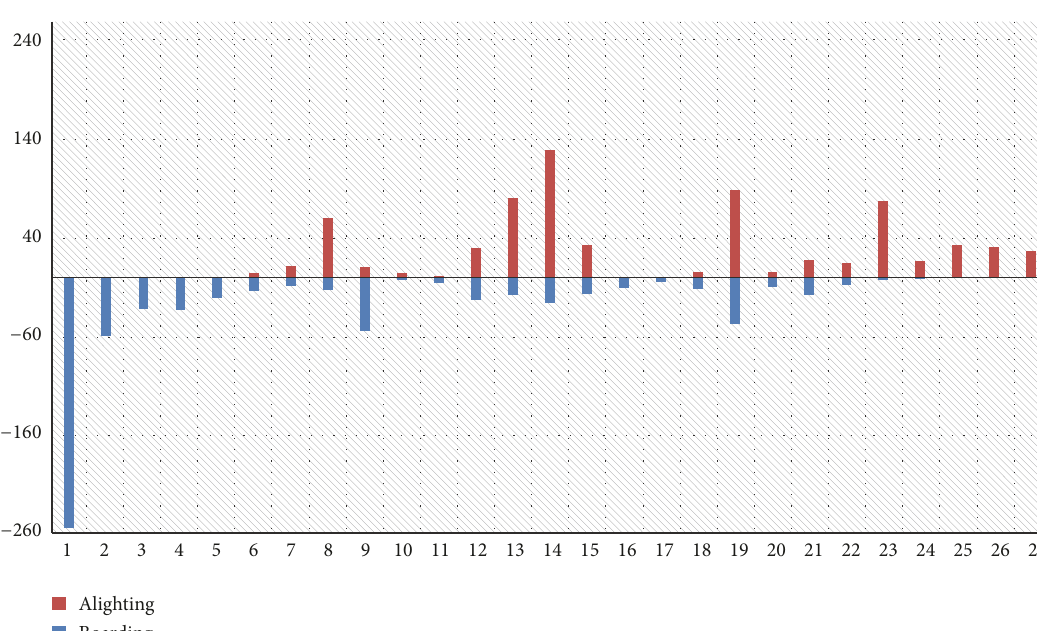
Figure 2: Boarding and alighting data of outbound